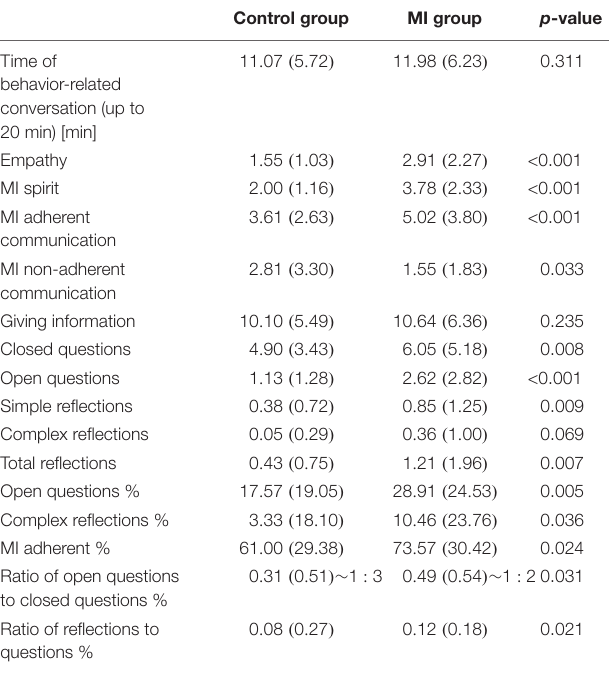
TABLE 5 | MITI-d analysis of the recorded conversations.